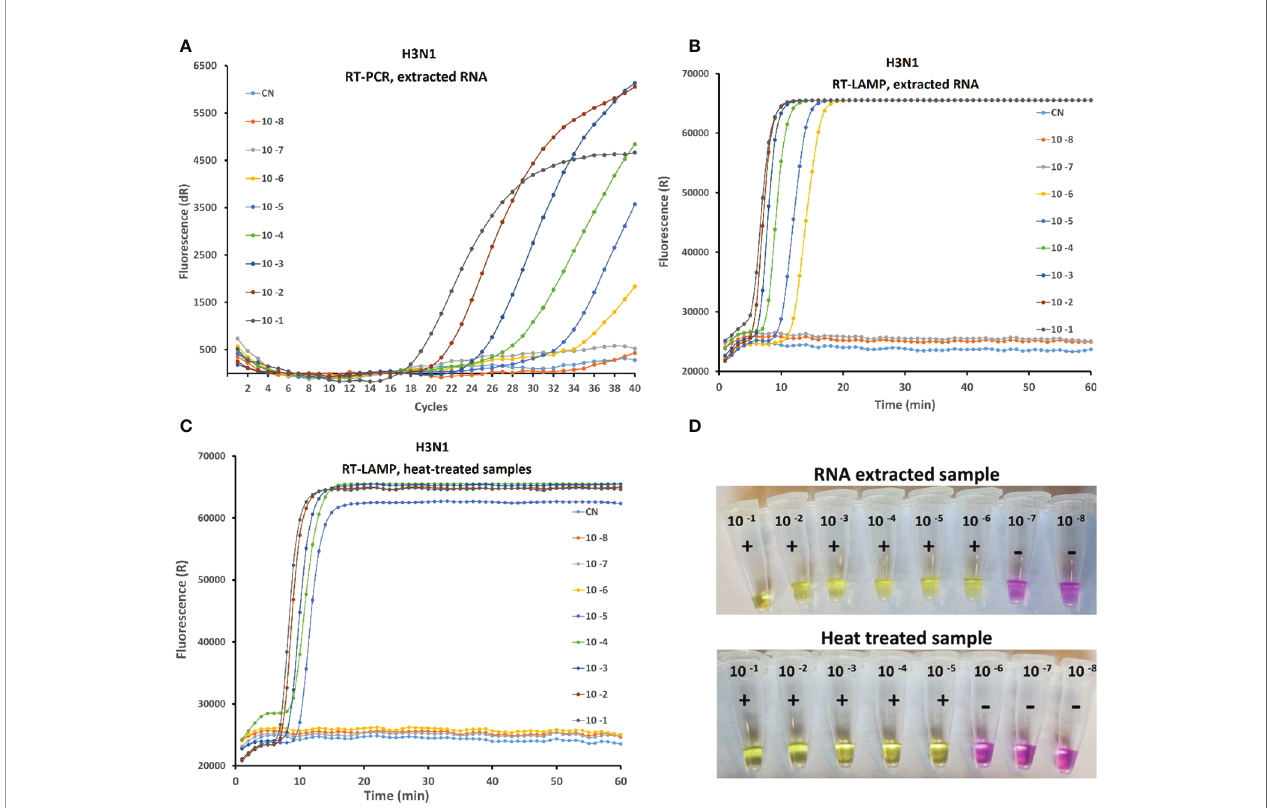
FIGURE 3 | Comparative study of the sensitivity of rRT-PCR, rRT-LAMP and on-site testing methods on serial 10-fold dilution of the H3N1 AIV sample with an initial viral titer of 10 8.5 EID 50 /mL. The RT-PCR ampli fi cation curve with puri fi ed RNA (A) RT-LAMP ampli fi cation curved with puri fi ed RNA (B) and with heat treated sample (C) and Onsite LAMP test using RNA extracted ( D up) and heat lysed samples ( D